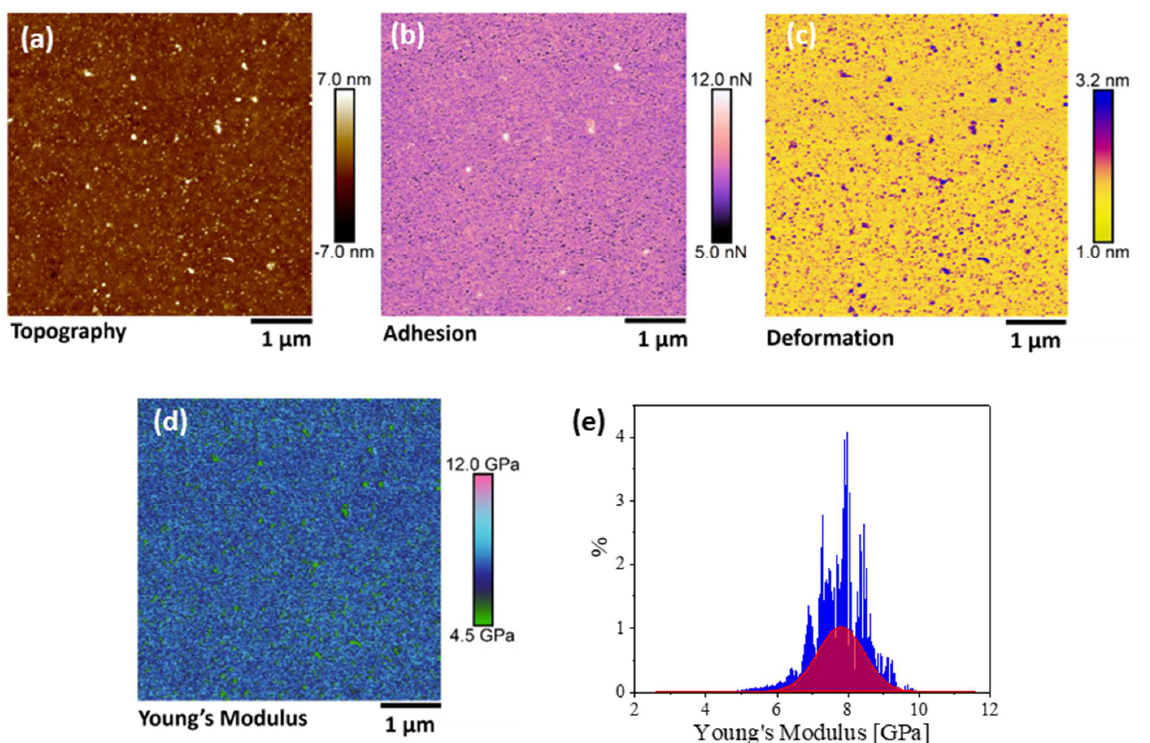
Figure 3. Typical nano-mechanical properties area of an area on a NBPS-CNM. The images display mappings of ( a ) Topography, ( b ) Adhesion, ( c ) Deformation, and ( d ) Young’s modulus. The white dots on the topography denote PMMA residues from the transfer of the membrane on the SiO 2 /Si substrate. ( e ) Histogram of the point-by-point analysis for the Young’s modulus mapping.